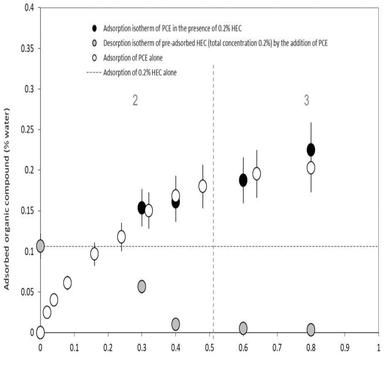
Desorption isotherm of pre-adsorbed HEC (dosage 0.2%) by the addition of PCE and simultaneous adsorption isotherm of PCE. PCE and HEC adsorption when they are alone in the system are also plotted. (regime 2) Gradual displacement of the HEC from the surface and (regime 3) total displacement of the HEC. Reproduced from with permission.